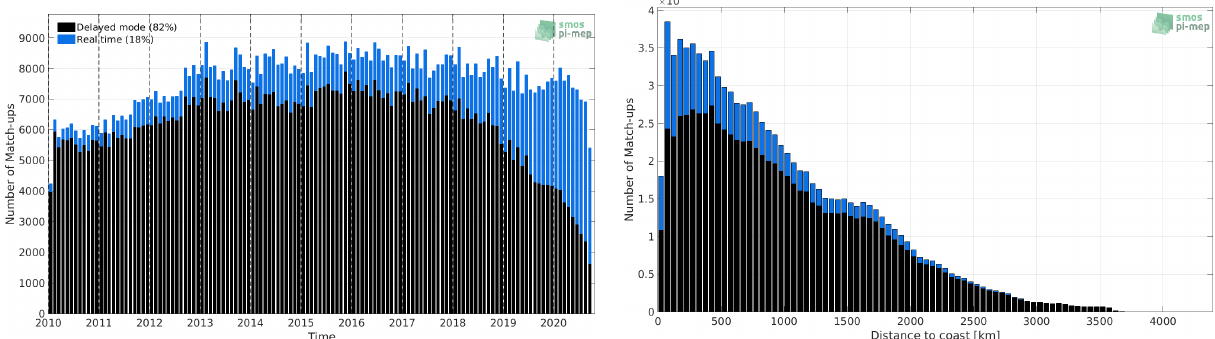
Figure 3. Number of match-ups between Argo and CCI SSS L4 Merged-OI v3.2—30-day running (ESA) SSS as a function of time ( left ) and as a function of the distance to coast ( right ) over the Global Pi-MEP region and for the full satellite product period.